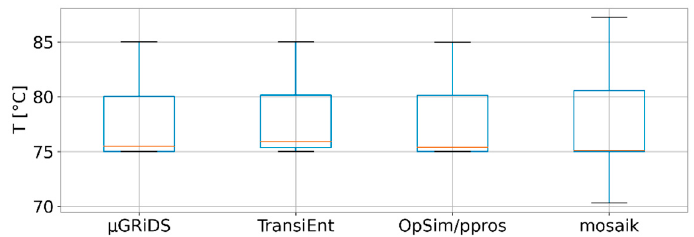
Figure 4. Mean temperature distribution of the different models for whole year.